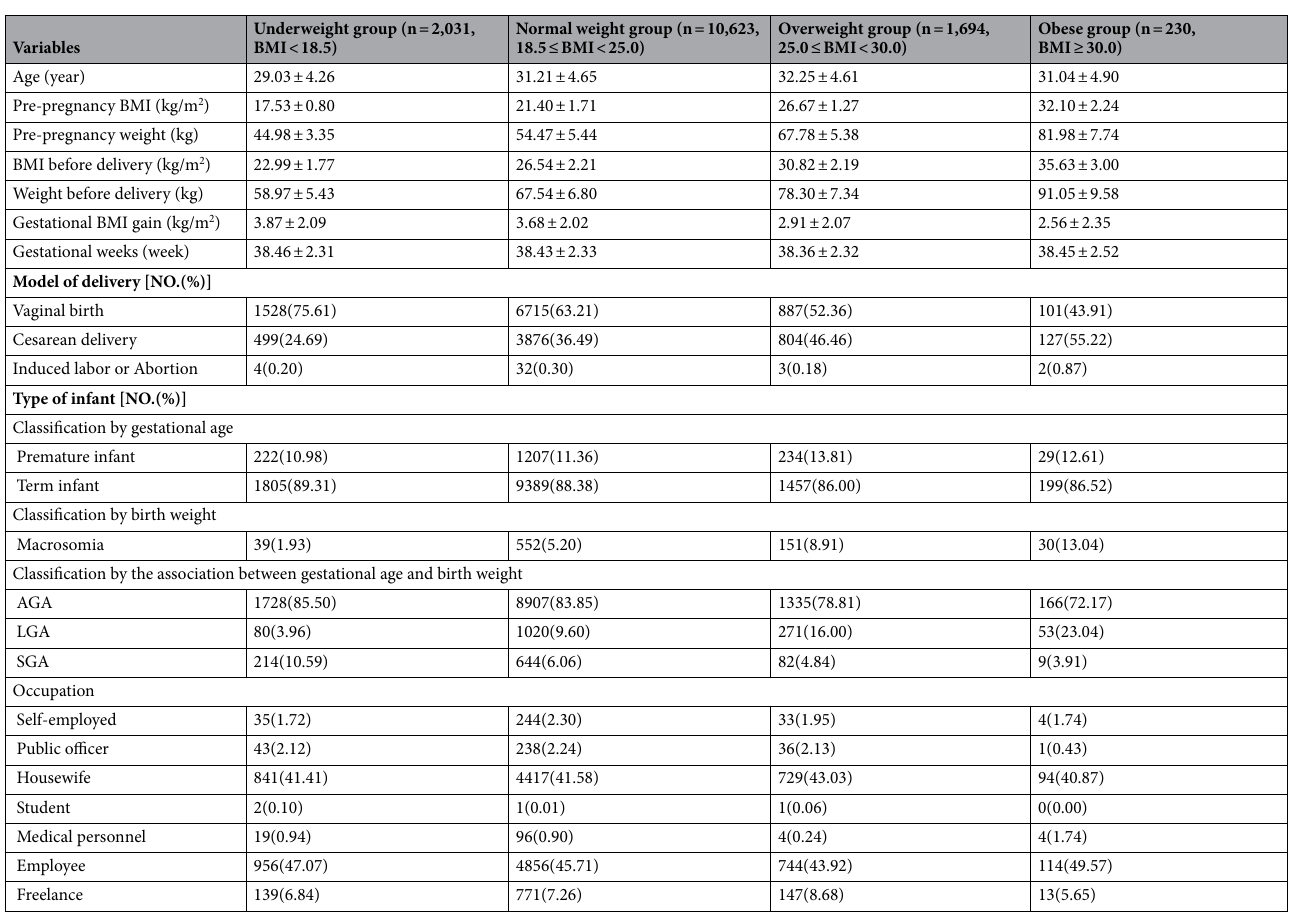
Table 1. The demographic and clinical characteristics of participants (n = 14,578). BMI body mass index, GWG Gestational weight gain, AGA appositeness for gestational age, LGA large for gestational age, SGA small for gestational